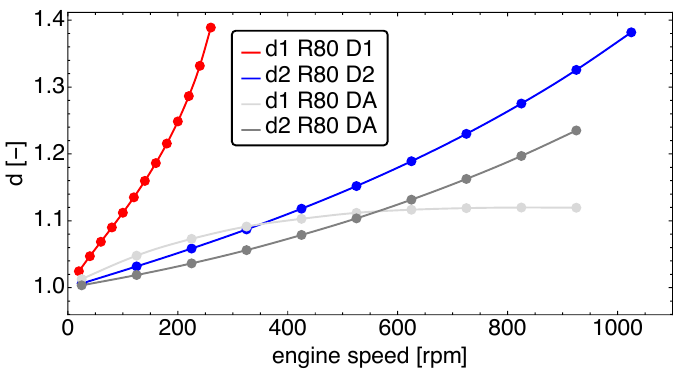
d Figure 8. The displacement ratios d 1 and 2 are shown as functions of the engine speed for the three engine designs D1, D2, and DA, and r = 0.8 regeneration extent. Note the growing increase of d 1 for the D1 design as well as the flattening out of d 1 for the DA